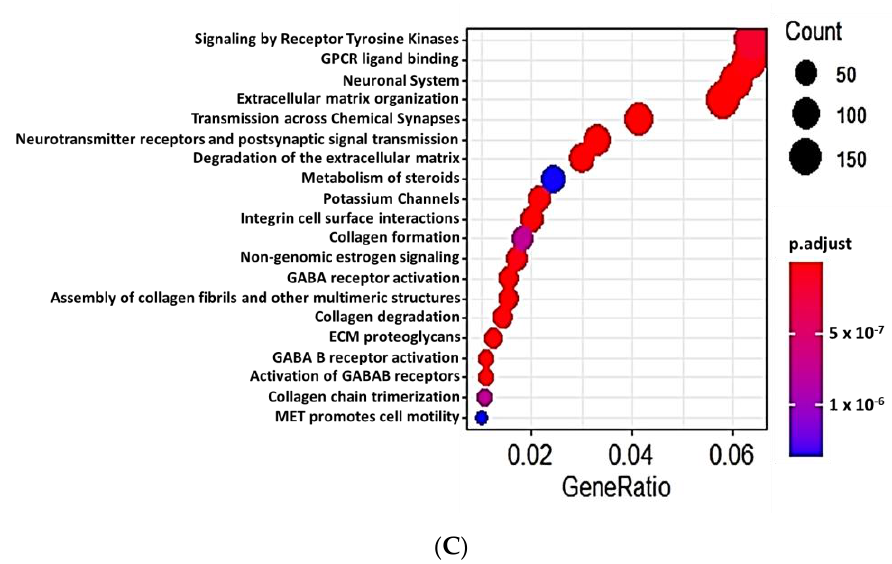
Figure 4. ( A ) Volcano plots of gene expression in adipocytes exposed to oxLDL (Ox) vs. control (CTL) (left panel) and oxLDL+ pNaKtide (OxP) vs. oxLDL (Ox) expression (right panel) plotting antilog of unadjusted p -value on y-axis vs. log 2 Fold Change on x-axis. Genes downregulated (unadjusted p -value < 0.1) by oxLDL colored orange and genes upregulated (unadjusted p -value of < 0.1) by oxLDL colored blue. We note that addition of pNaKtide expression moved upregulated genes down and downregulated genes up. ( B ) Gene Ontology summary of over representation analysis (ORA) in oxLDL treated murine adipocytes. Gene ontology annotation of biological processes, cellular components and molecular function categories. ( C ) Reactome ORA of differentially expressed genes in oxLDL treated murine adipocytes. The scatter dot plot of reactome enrichment representing the number of differentially expressed genes enriched in GO terms.